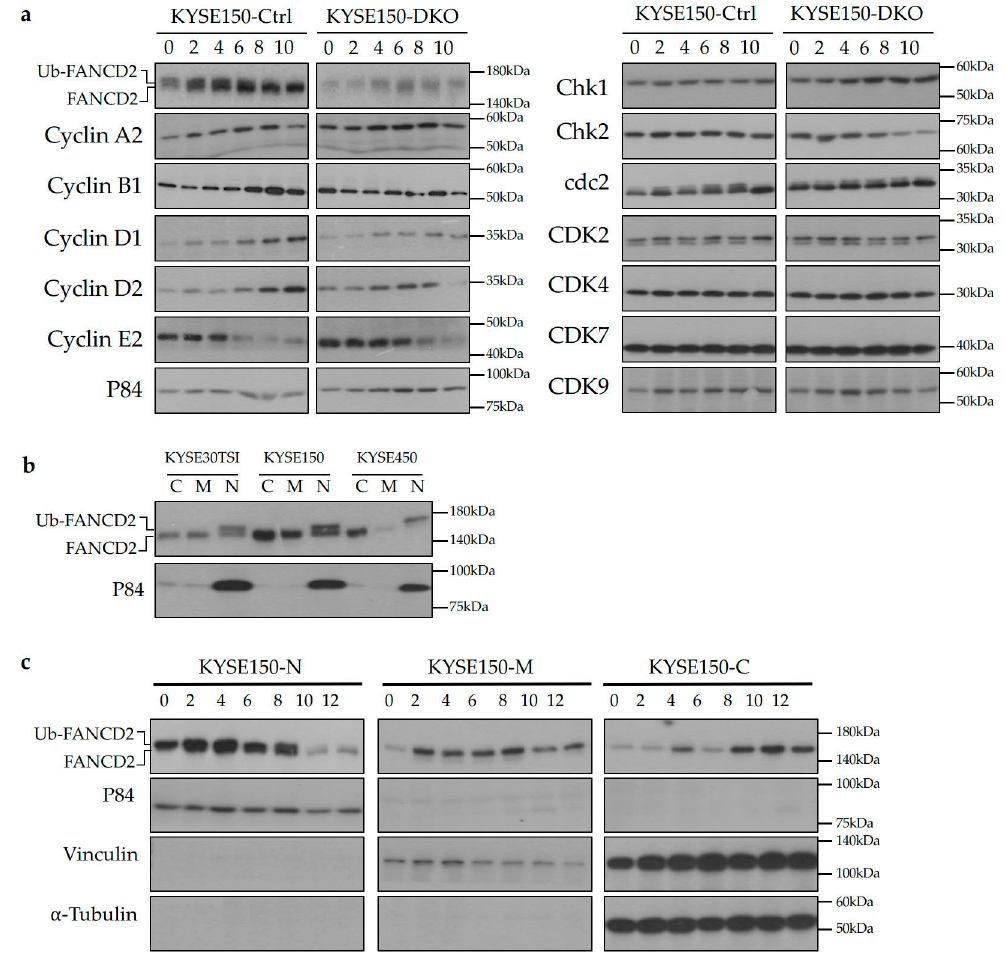
Figure 5. Analysis of cell cycle markers and FANCD2 subcellular localization. ( a ) FANCD2-KO induced alterations in the expression of cyclin proteins that are essential for cell cycle progression. The protein lysates were collected at the indicated time points after double-thymidine block and analyzed by Western blotting. ( b ) Western blotting analysis showed mono-ubiquitination of FANCD2 only in the nucleus. ( c ) Western blotting analysis of FANCD2 protein in various cellular fractions at the indicated time points after double-thymidine block. N, nuclear fractions; M, membrane fractions; C, cytoplasmic fractions; Ctrl, control; DKO, FANCD2 knockout; p84, loading control; Vinculin, loading control; α -Tubulin, loading control.